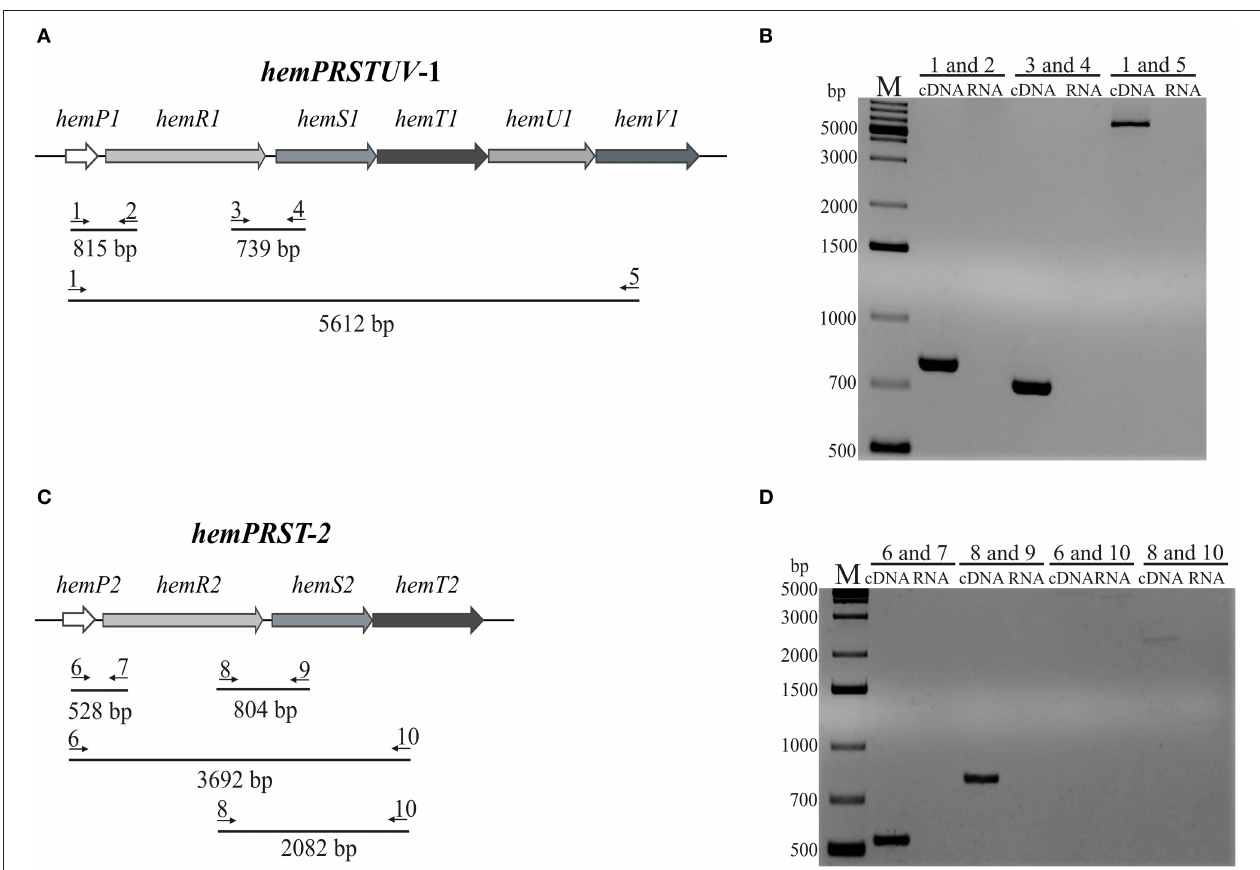
FIGURE 3 | sqRT-PCR analysis of the hemPRSTUV- 1 and hemPRST -2 gene clusters of Y. enterocolitica Ye9. (A,C) Scheme showing primers used in sqRT-PCR analysis of hem clusters 1 and 2. The sequences of the following primers are listed in Table S2 . 1, RThPR1F; 2, RThPR1R; 3, RThRS1F; 4, RThRS1R; 5, RThPV1R; 6, RThPR2F; 7, RThPR2R; 8, RThRS2F; 9, RThRS2R; 10, RThPT2R. (B,D) Agarose gel electrophoresis of sqRT-PCR products from hem clusters 1 and 2. Total RNA isolated from strain Ye9 grown in iron-depleted LBD medium (LB with the iron chelator 2,2 ′ -dipyridyl) at 37 ◦ C was DNase I treated and then reverse transcribed with random hexamers. The obtained cDNA was used as a template in PCR reaction with pairs of primers shown in (A) and (C) . RNA was used as the template in negative control reactions. M, GeneRuler 1kb DNA